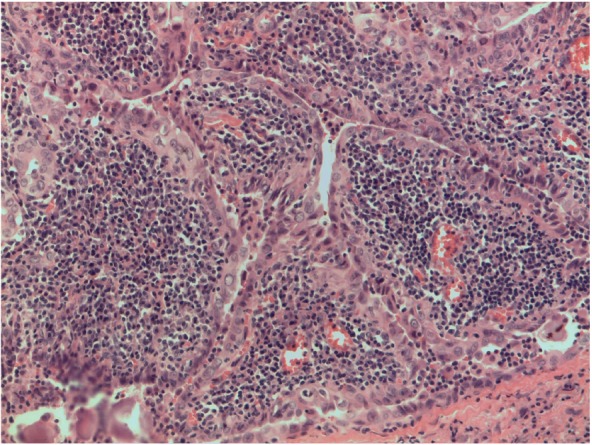
Papillary carcinoma Warthin-like with classical features of Warthin tumor; papillary growth, lymphocytes rich stroma and thyrocytes with papillary nuclear features. X400 magnification.